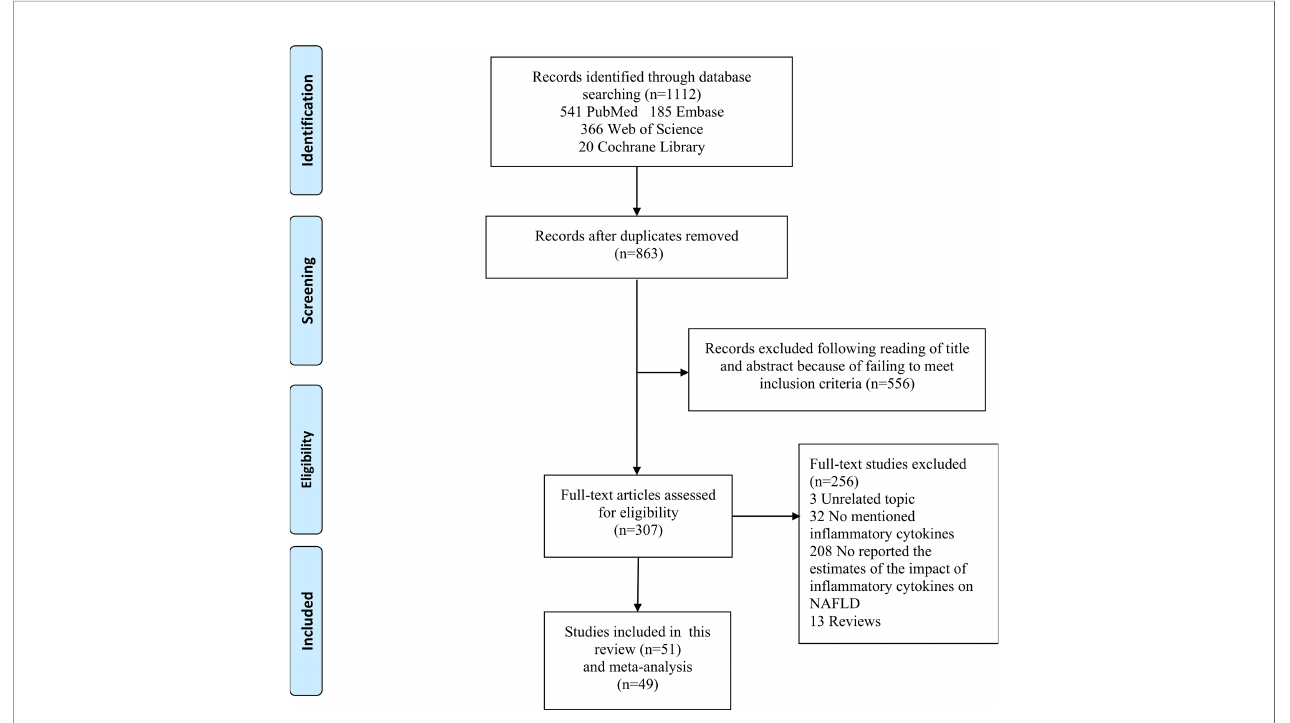
FIGURE 1 | Flowchart of study inclusion and